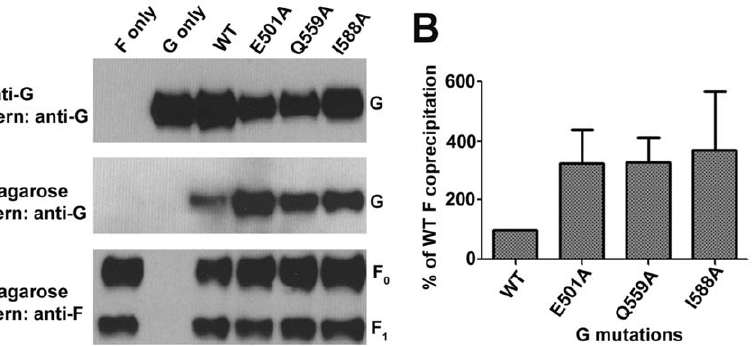
Figure 9. Interaction of HeV-G mutants with HeV-F. (A) HeV-G mutants were co expressed with S tagged HeV-F in HeLa-USU cells. Lysates were immunoprecipitated (IP) with rabbit polyclonal G-specific antiserum to evaluate total G expression (top panel) or S agarose to evaluate total F expression (bottom panel) and co-precipitation of G (middle panel). The precipitated products were analyzed on SDS-PAGE under reducing conditions and then western blot analyzed with F (bottom panel) or G (top and middle panel) specific mouse mAbs. The western blot result of one of three independent experiments is shown in (B). The relative HeV-F binding ability of each HeV-G mutant is shown in comparison to that of WT HeV-G and normalized to total HeV-G expression and the means of three independent experiments are shown. Error bars represent the ranges. The results were calculated using values obtained from digital densitometric measurements of the images.